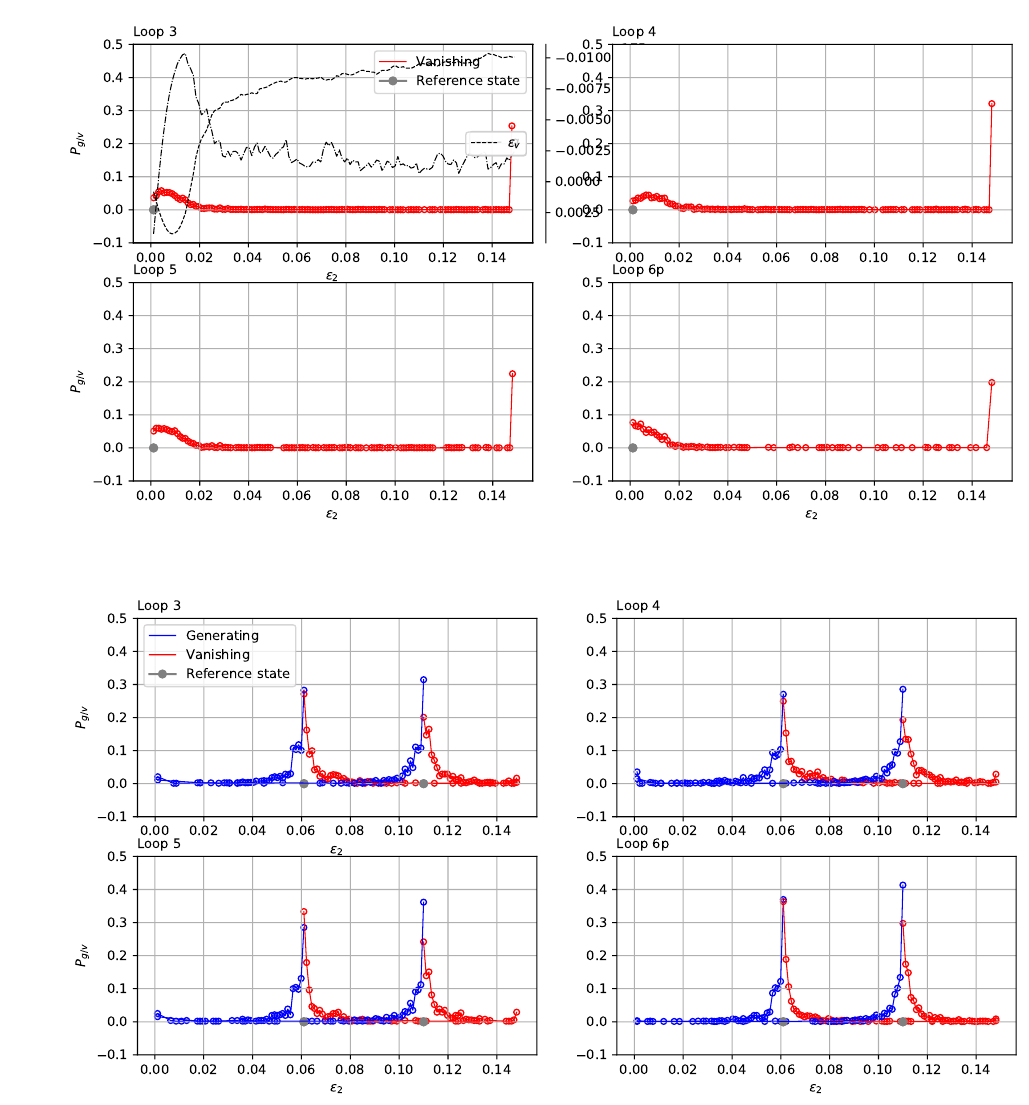
Figure 5. Lifespan and life expectancy probabilities of grain loops at the initial state considering the whole sample (I) and two critical states within the shear band